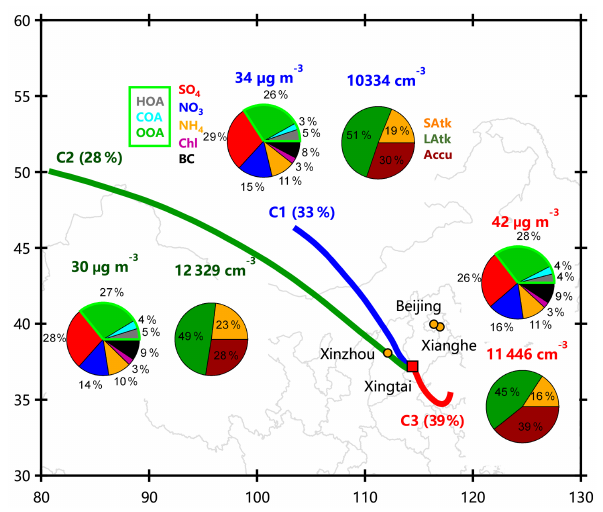
Figure 12. Average composition of aerosol particles and particle number concentration for three different